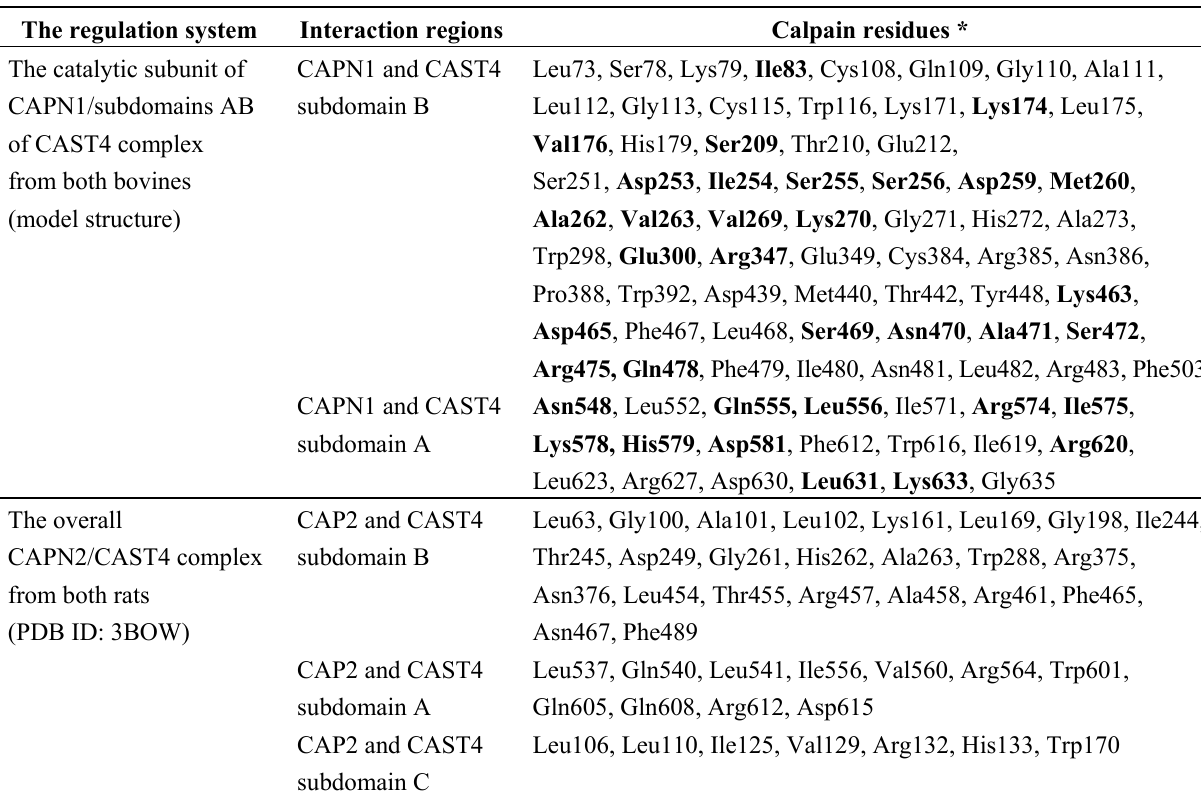
Table 5. Key interaction contacts in the CAPN1/CAST4